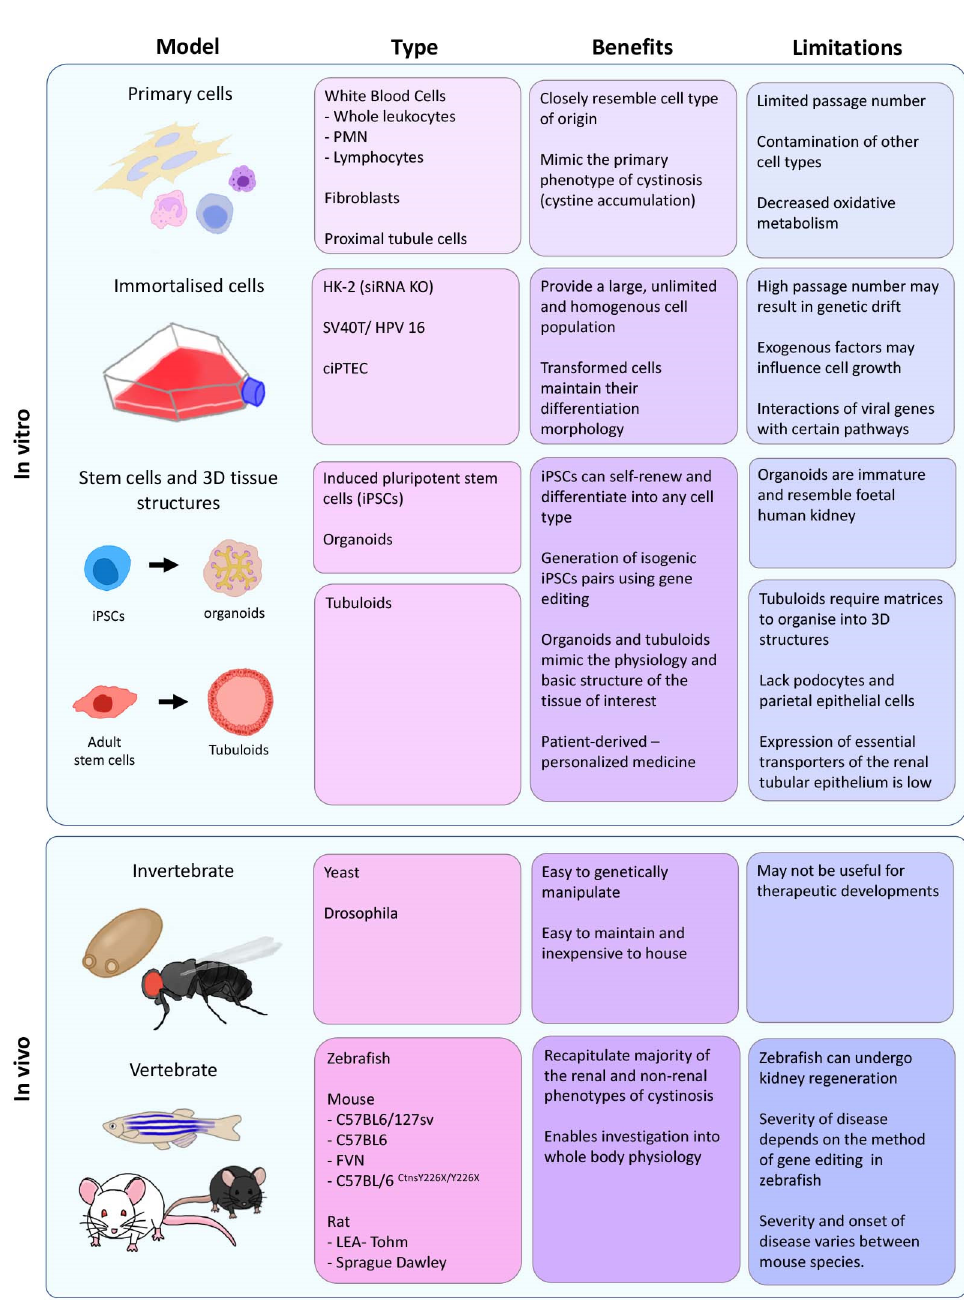
Figure 1. Schematic overview summarising the different in vitro and in vivo cystinotic models. PMN = polymorphonuclear; HK-2 = human kidney-2; SV40T = simian virus 40 large T antigen; HPV 16= human papillomavirus type 16; ciPTEC = conditionally immortalised proximal tubule epithelial.